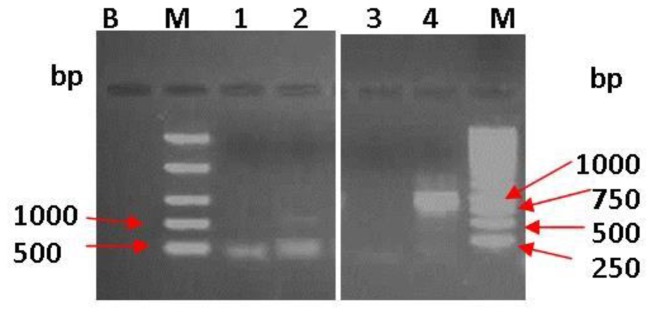
Agarose gel electrophoresis of PCR products of total genomic DNAs with primers targeting gene nccA (Lane: 4), van2 (lane: 3), smtAB (lane: 2) and cnrB2 (lane: 1).Lanes: M: DNA ladder (Marker) and B: Negative (No template DNA).